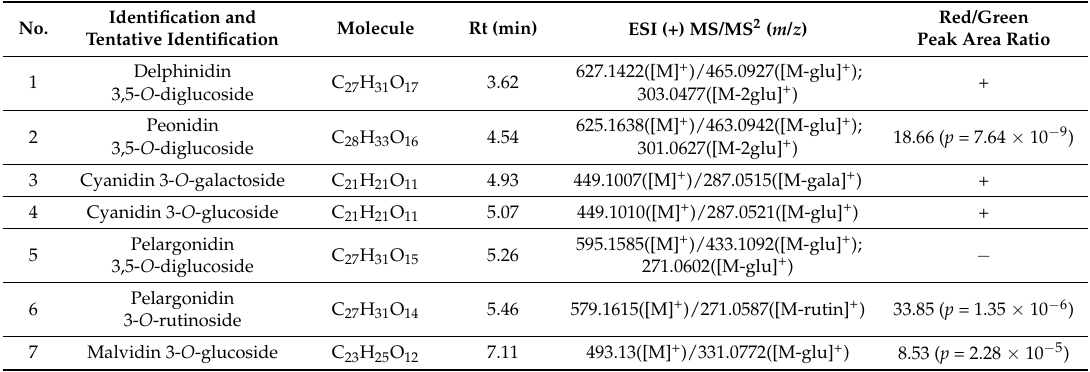
Table 1. UPLC-QTOF-MS identification of anthocyanins in D. officinale